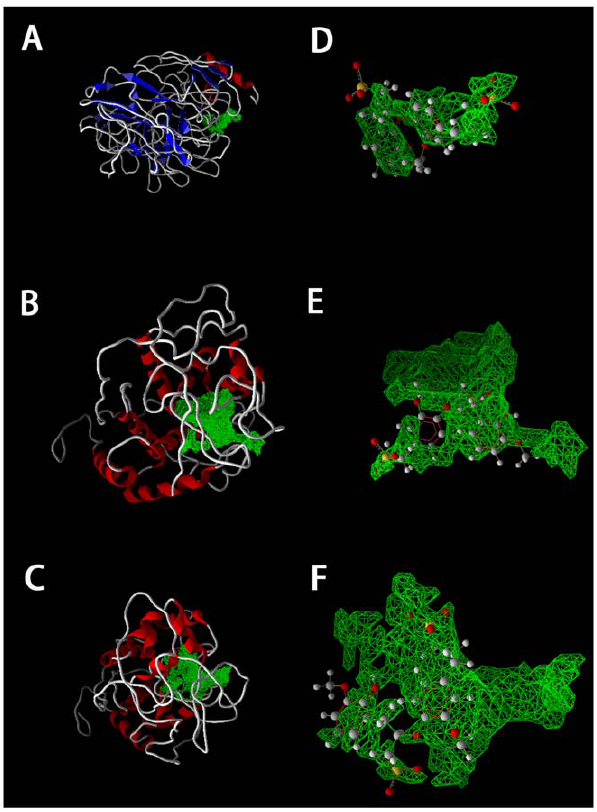
Figure 1. Binding pockets and binding orientations of lignin in the best docking Lac-lignin, LiP-lignin and MnP-lignin com- plexes. Panels A, B and C display the binding pockets of Lac, LiP and MnP, respectively, whereas panels D, E and F show the binding orientations of Lac, LiP and MnP, respectively. The 3D structures of Lac, LiP and MnP are represented in Cartoon style. The green grids show the binding pockets of lignin-enzymes. The lignin is clearly showed in ball and stick model (colored by element: gray , carbon; red , oxygen; white , hydrogen; yellow , sulfur).